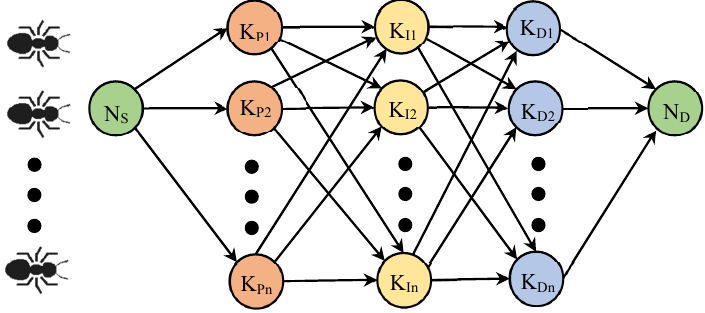
Figure 8. ACO Graphical Representation for the Purpose of PID